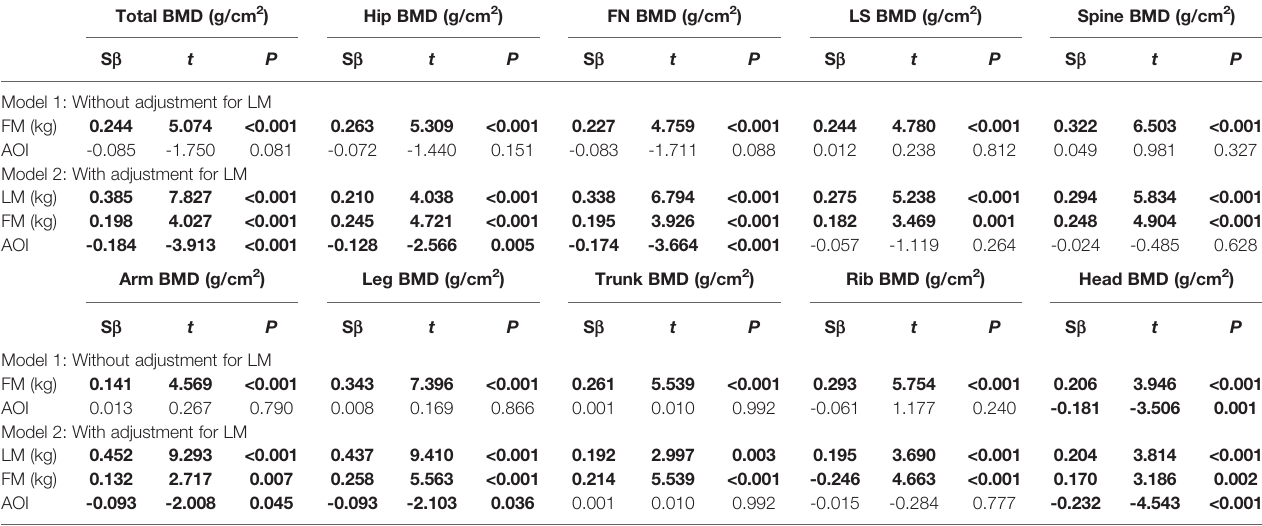
TABLE 4 | Regression analysis of FM, AOI, and LM with total body and regional BMD. Total BMD (g/cm 2 )